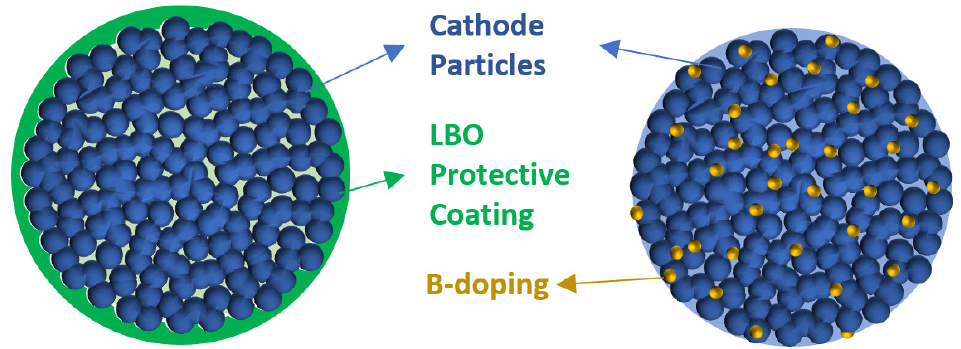
Figure 4. Schematic of two improvement approaches of using boron compounds in cathode.